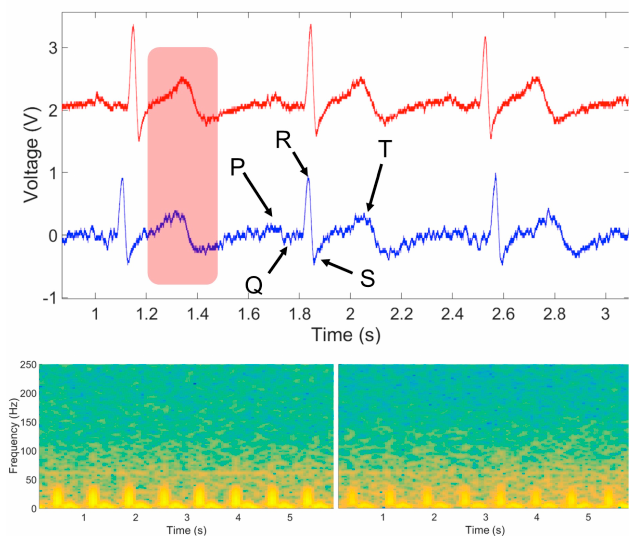
Figure 9. The ECG signal collected by two electrodes for comparison (Red) Commercial gel electrode, GS-26, and (Blue) PPy coated pvCNT. (Bottom) Time-frequency analysis (Left: GS-26, Right: PPy coated pvCNT) show similar performance and noise characteristics.